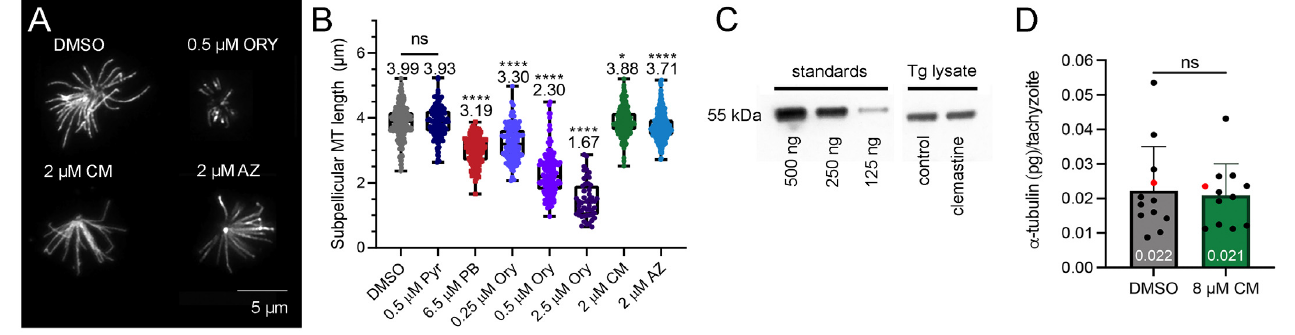
Figure 4. Quantification of Toxoplasma tubulin protein and microtubule length. ( A ) Tubulin immunofluorescence of drug- treated, DOC-extracted tachyzoites permits visualization of stable subpellicular microtubules. ( B ) Individual microtubule lengths were measured in ImageJ, and the distribution of lengths is shown for control and drug-treated samples. Statistical analyses were run using mixed-effects analysis. The results represent the average of 300 measurements (3 biological rep- licates with 100+ individual microtubules counted for each treatment) ± standard deviation. ( C ) Tubulin immunoblots probed with an anti-tubulin monoclonal antibody, detected with HRP conjugated secondary antibody. Protein samples contain defined numbers of Toxoplasma tachyzoites, and parasite tubulin was quantified relative to purified tubulin stand- ards of known concentration. ( D ) Known porcine standard concentrations plotted against band intensity were used to calculate the concentration of α -tubulin in parasite samples. The red dots indicate the values for the blot data shown in C. Values were normalized to Toxoplasma equivalents, and statistical analyses were run using an unpaired t-test. The results represent the average of 12 measurements (3 biological replicates with triplicate or more technical replicates) ± standard deviation. Abbreviations: Pyr: pyrimethamine; PB: parabulin; Ory: Oryzalin; CM: clemastine; AZ: astemizole. ****: p values less than 0.0001; *: p values less than 0.05; ns.: >0.05, not